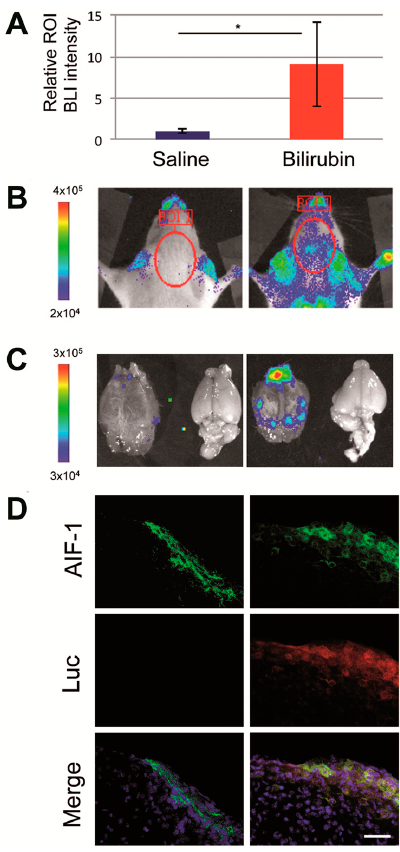
Figure 3. Effects of intra peritoneal injection of bilirubin into MITO-Luc mice. Representative MITO- Luc mouse ( n = 5 per group) receiving saline solution or bilirubin (50 mg/kg) were analyzed 1 day after administration. ( A ) Relative bioluminescence intensity assessed by Living Imaging software; the asterisk (*) indicates a signi fi cant difference versus the control group ( p ≤ 0.05); ( B ) bioluminescence imaging (BLI) of live animals; ( C ) BLI imaging of brain after necropsy. The color scale next to the images indicates radiance, with red and blue respectively representing the highest and lowest bioluminescent signals, expressed in photons/s/cm 2 /sr; ( D ) Representative immunohistochemical images of lateral sagittal brain sections including middbrain and substantia nigra from saline- ( left panels) and bilirubin-treated mice ( right panels), stained with antibodies anti-allograft inflammatory factor 1 (AIF-1, green), antibodies anti-luciferase (Luc, red), and relative merged images with 4 ′ ,6- diamidino-2-phenylindole (DAPI, blue) staining. Scale bar: 100 µm. BLI was also performed after necropsy on brains of selected animals sacrificed 1 day after